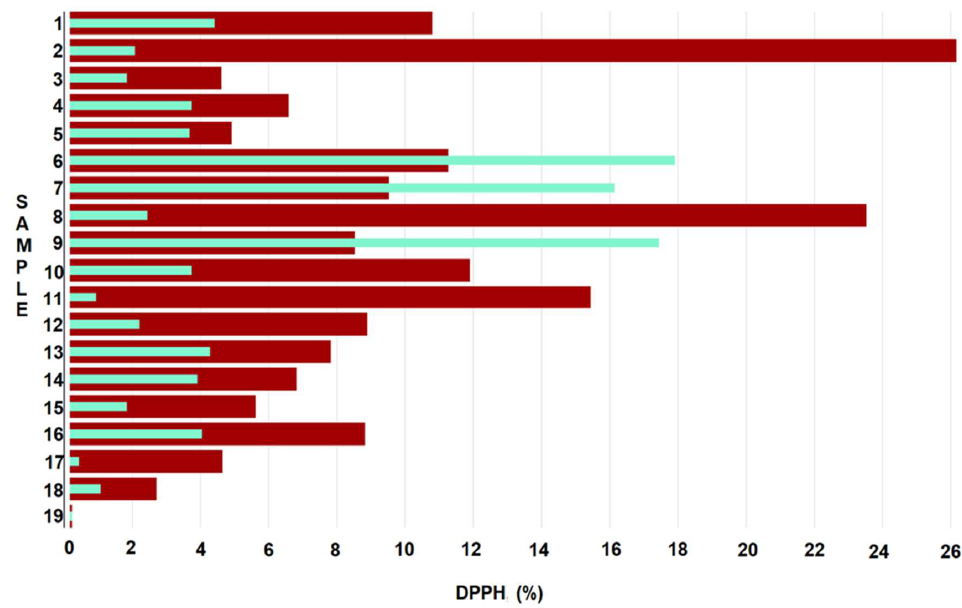
Figure 7. Graphical representation of DPPH radical scavenging activity of biopolymeric films before (red) and after storage (turquoise).